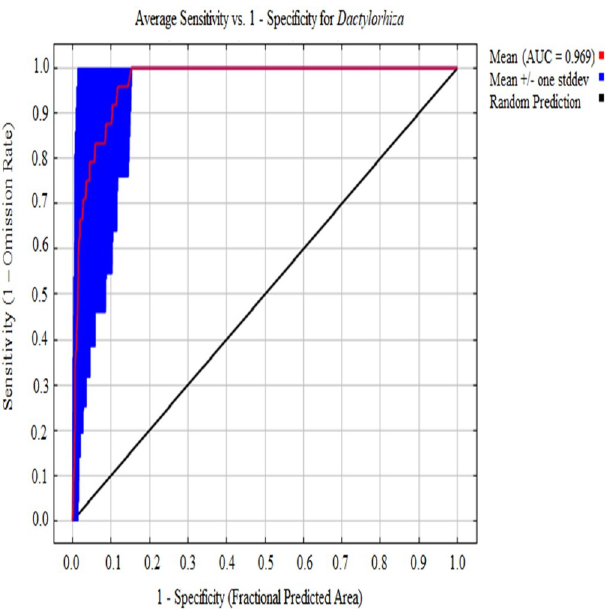
Fig 3. Receiver operating characteristic curve with area under the curve (AUC) signifying model robustness.